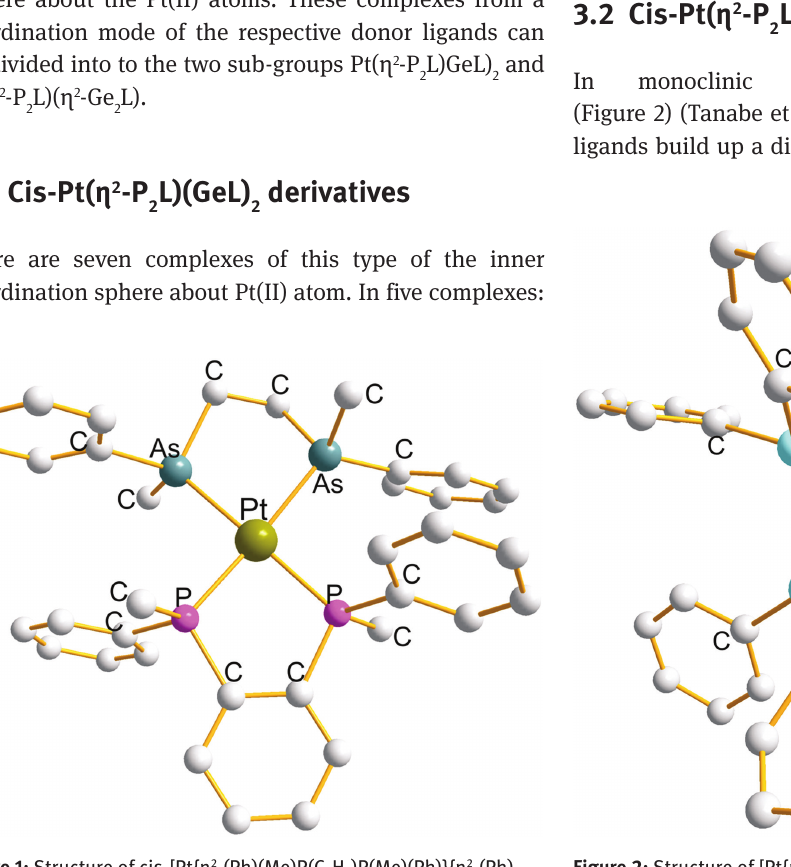
P(CH ) PMe }{η 2 -(GePh 2 2 2 2